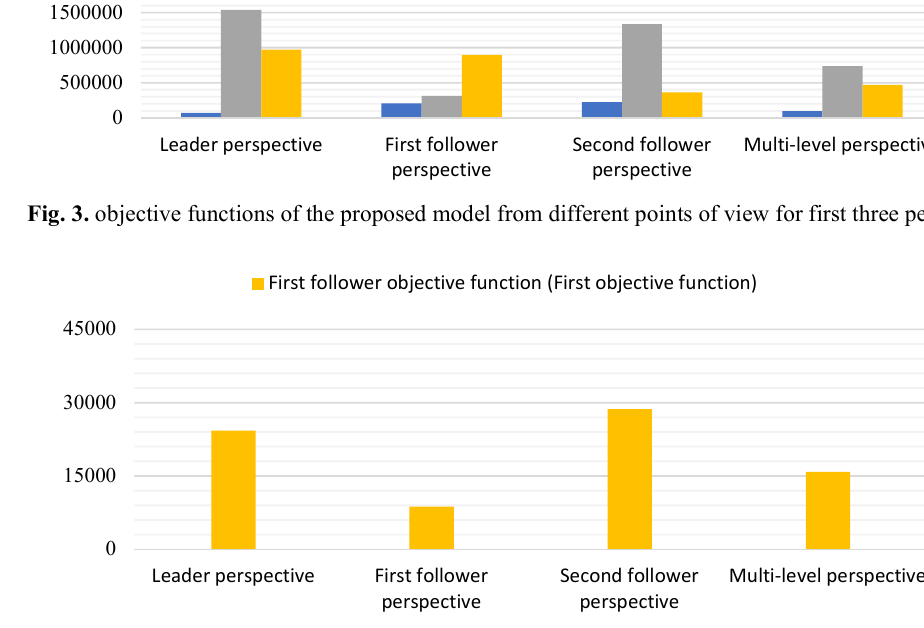
Fig. 4. the government’s first objective function of the proposed model from different points of view for first three periods